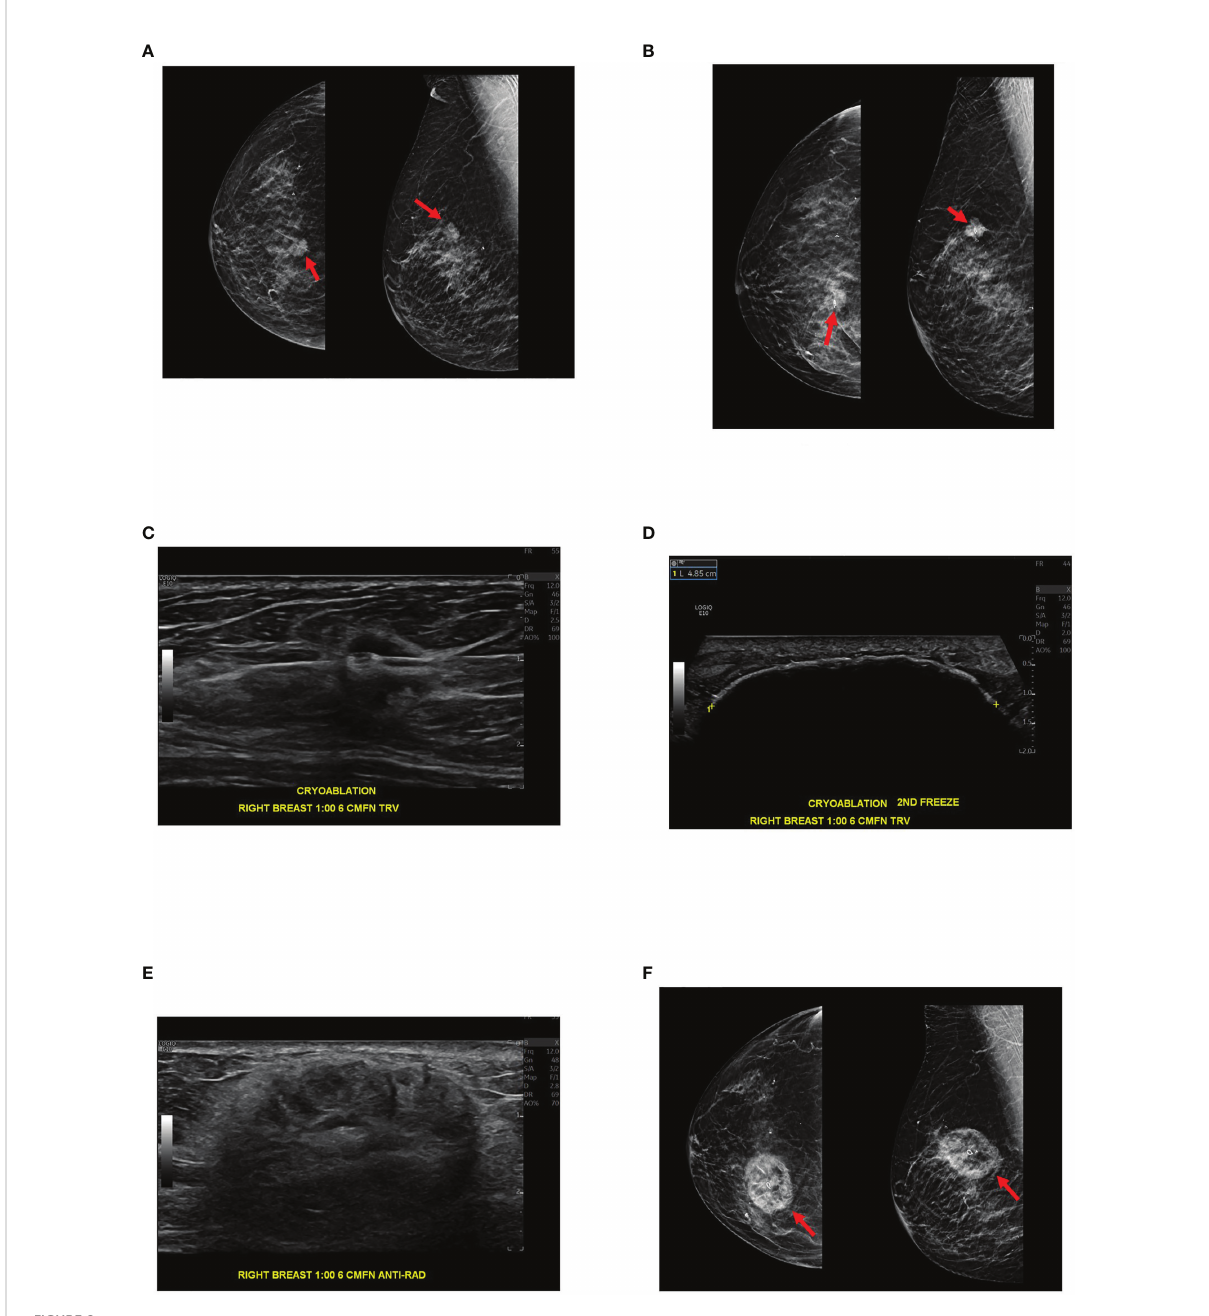
FIGURE 2 89-year-old female with biopsy-proven 1.3 cm right breast invasive ductal carcinoma, Nottingham histologic grade 2, ER/PR + HER2 -, presents for cryoablation. (A) Mammographic images with digital breast tomosynthesis CC (craniocaudal, left image) and MLO (mediolateral oblique, right image) projections demonstrate a suspicious high-density spiculated mass within the right breast at 1 o ’ clock, posterior depth. Ultrasound- guided biopsy was subsequently performed (not pictured). (B) Digital breast tomosynthesis CC (left image) and ML (mediolateral, right image) projections demonstrate the biopsy clip centered within the mass following ultrasound-guided tissue sampling. Pathology was consistent with invasive ductal carcinoma. (C) Ultrasound demonstrates cryoablation probe placement through the target lesion before initiation of the fi rst freeze cycle. (D) Ultrasound shows the ice ball enveloping the target lesion and the surrounding tissues at the conclusion of the procedure, immediately after the second freeze cycle. Note the ice ball long axis measures 4.9 cm. (E) Three months after cryoablation, ultrasound demonstrates expected post cryoablation changes as a mixed echogenic mass surrounding the ablated tumor. (F) Three-month post cryoablation digital breast tomosynthesis CC and MLO projections demonstrate expected post cryoablation changes with the biopsy clip centered within the ablation zone, con fi rming appropriate cryoablation